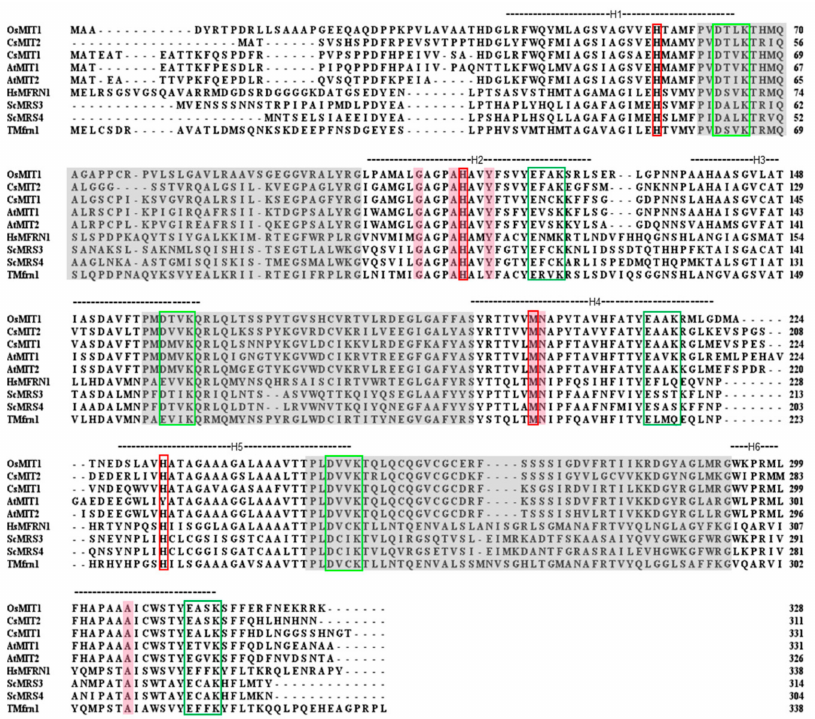
Figure 1. In silico analysis of MIT proteins from yeast, human, fish, and monocotyledonous and dicotyledonous plants. Sequence alignment of rice (OsMIT1), Arabidopsis (AtMIT1 and AtMIT2), cucumber (CsMIT1 and CsMIT2), human (HsMfrn1), yeast (ScMRS3, ScMRS4) and O. niloticus (TMfrn1) generated using Clustal O. Grey highlights represent the characteristic sequence motif of MCs (P-x-[DE]-x-[LIVAT]-[KR]-x-[LRK]-[LIVMFY]-(20-30 residues)-[DE]-G-x-x-x-x-[WYF]-[KR]-G). Transmembrane helices predicted for these proteins are depicted by H1-H6. Putative substrate contact sites are highlighted in pink, and the residues involved in iron transport are marked in red boxes. Green boxes represent the conserved motifs forming salt bridges on the cytosolic (dark green) and matrix (light green)